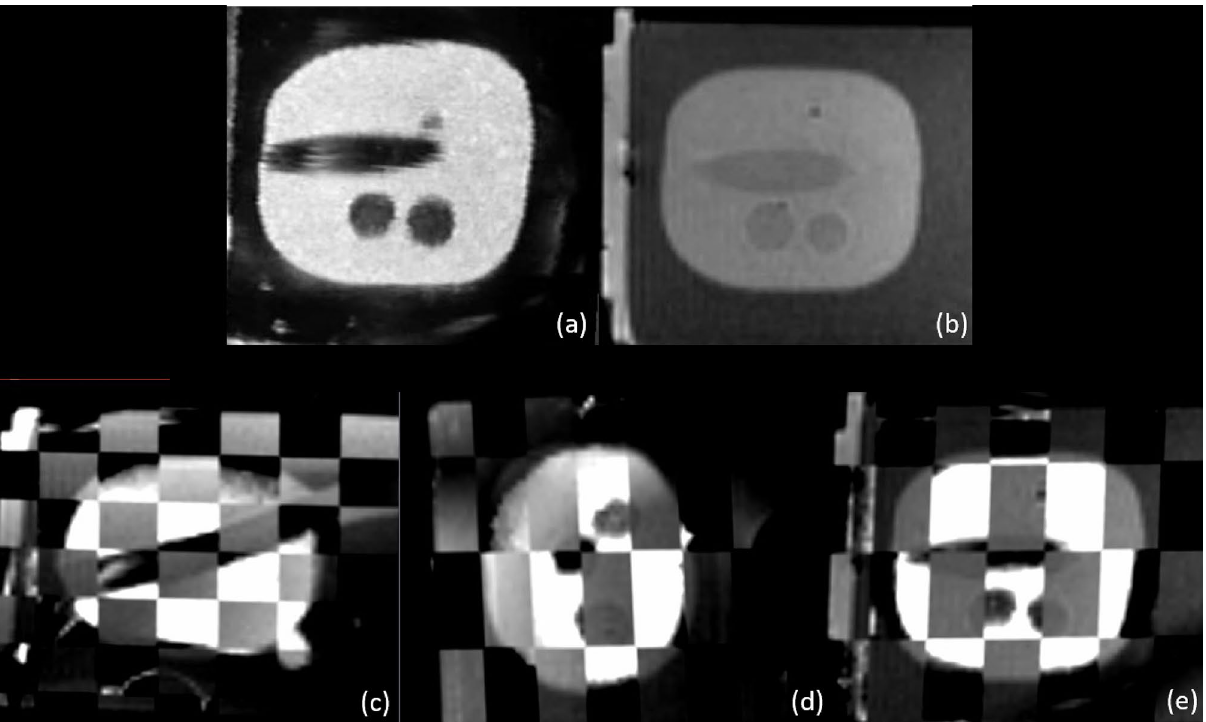
Figure 8. Coronal views of the prostate phantom images from the 3D-TRUS ( a ) and from the MR ( b ) and images from the axial ( a ), sagittal ( b ) and coronal ( c ) planes with the registered MRI and the 3D-TRUS images using the prostate phantom. From this registration the Dice score was calculated from the segmented